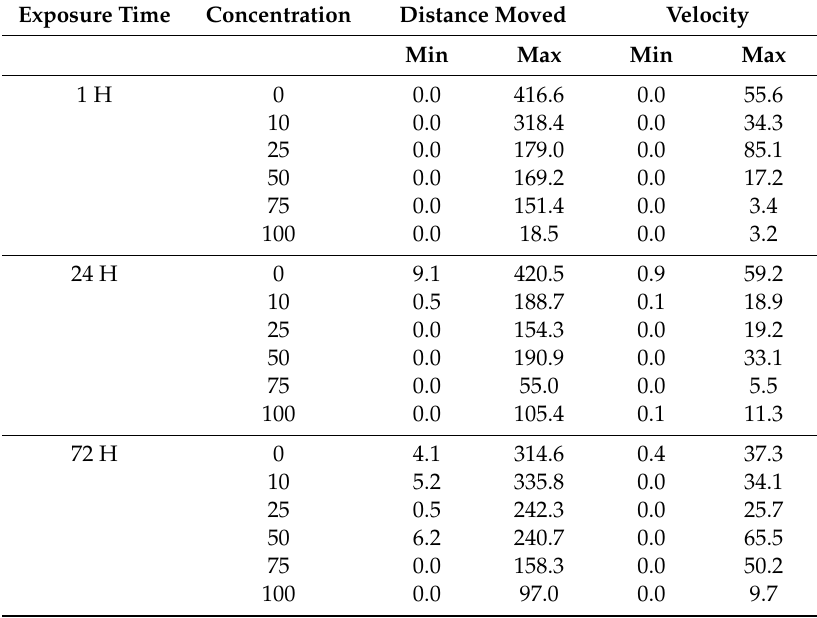
Table 3. Minimum (Min) and maximum (Max) values for total distance moved (in cm) and instantaneous velocity (Velocity, cm / min) for C. ferrugineus during 10 min trials after 1, 24, and 72 h of exposure to the combination treatment of deltamethrin + methoprene + piperonyl butoxide synergist, with a total of n = 15 individuals tested per treatment